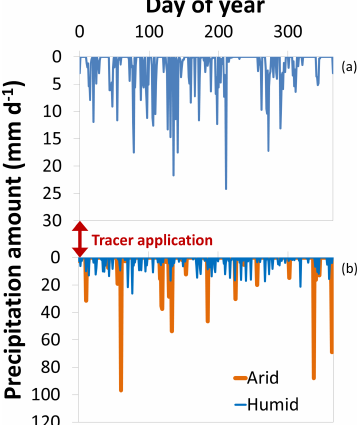
Figure 2. (a) 1-year time series of subsequent precipitation (looped 32 more times for the entire modeling period and rescaled for smaller or larger amounts of subsequent precipitation P sub ). Tracer application took place during the first hour of the model runs. (b) Time series of subsequent precipitation for a high-frequency scenario (humid) and a low-frequency scenario (arid). The total pre- cipitation amount is the same for both scenarios.